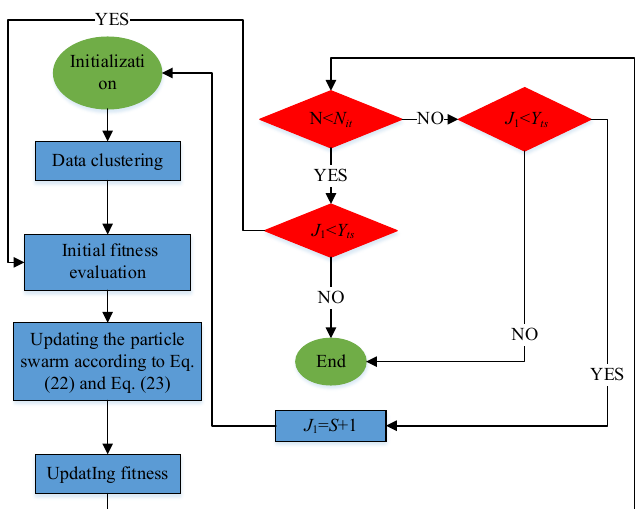
Figure 3. Flow chart of ICF-PSO for optimizing the number and parameters of PWA local